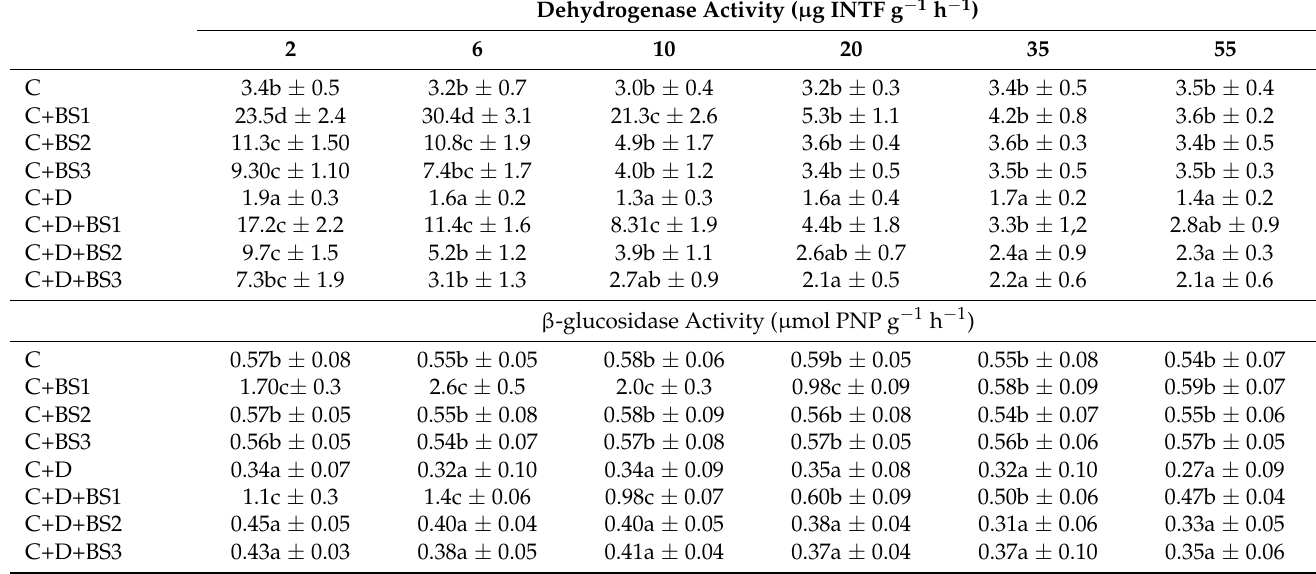
Table 3. Evolution of dehydrogenase and β -glucosidase activities (mean ± standard error, n = 3) in soils amended with the three experimental biostimulants and polluted with diuron during the experimental period.